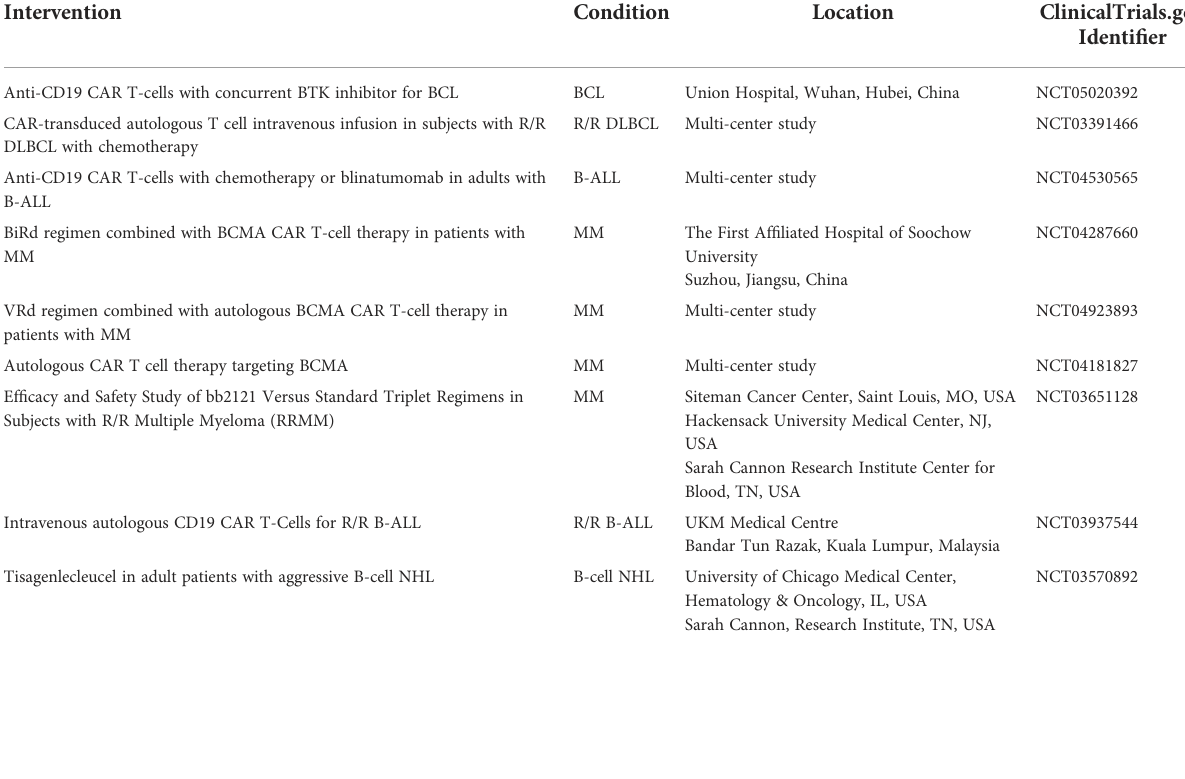
TABLE 2 Ongoing and currently recruiting phase III clinical trials involving CAR T-cell therapies for hematologic malignancies